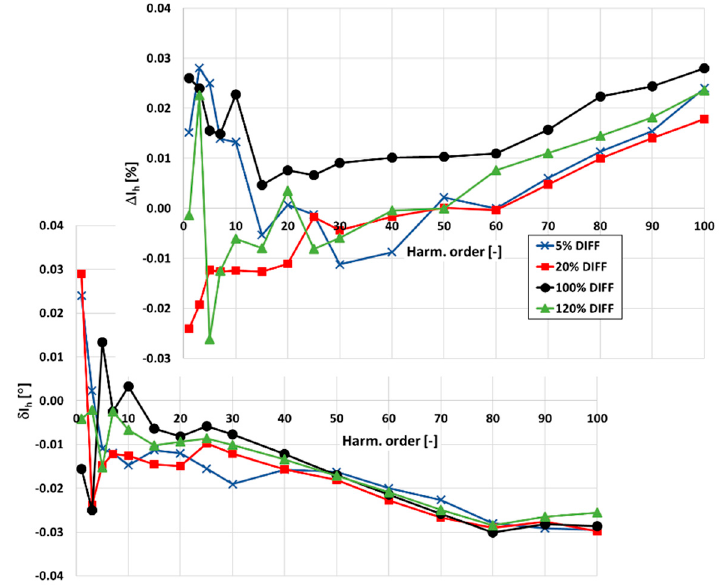
Figure 12. The differences in values of current and phase errors at harmonics measured between CTs 300\5 A and for each CT in the condition of ampere-turns.